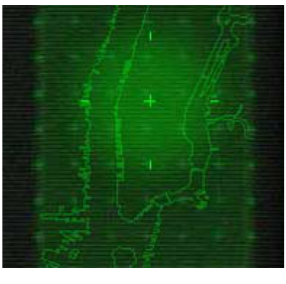
Fig. 2: Part of an interface. H. Minami, Infrasonic Soundscape , http://meccano.trovarsinrete.org/archivi/issue06/infrasonic.htm, retrieved: 10. 10.